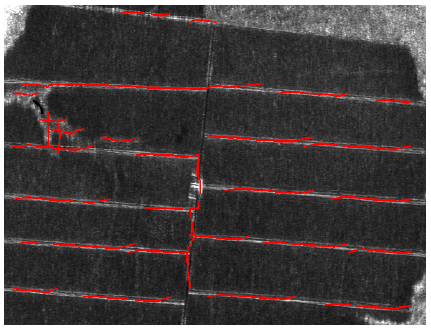
Figure 9: Results of the road extraction method (Cut 2).